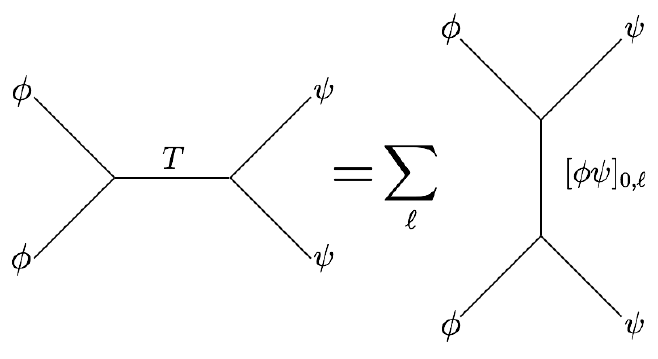
Figure 3 . Correction to [ (cid:30) ] due to T